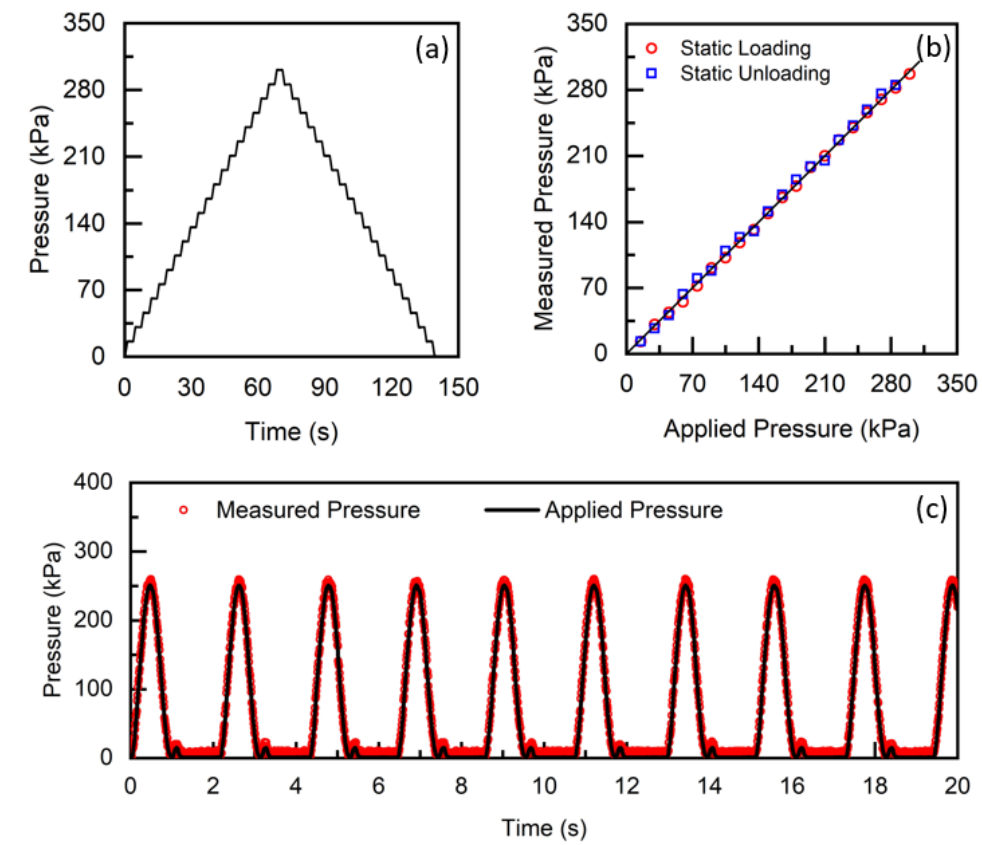
Figure 4. ( a ) Applied static pressure from the Instron mechanical test machine as a function of time. Measured pressure from the insole system and applied pressure from the test machine, obtained from the ( b ) static and ( c ) dynamic pressure test.